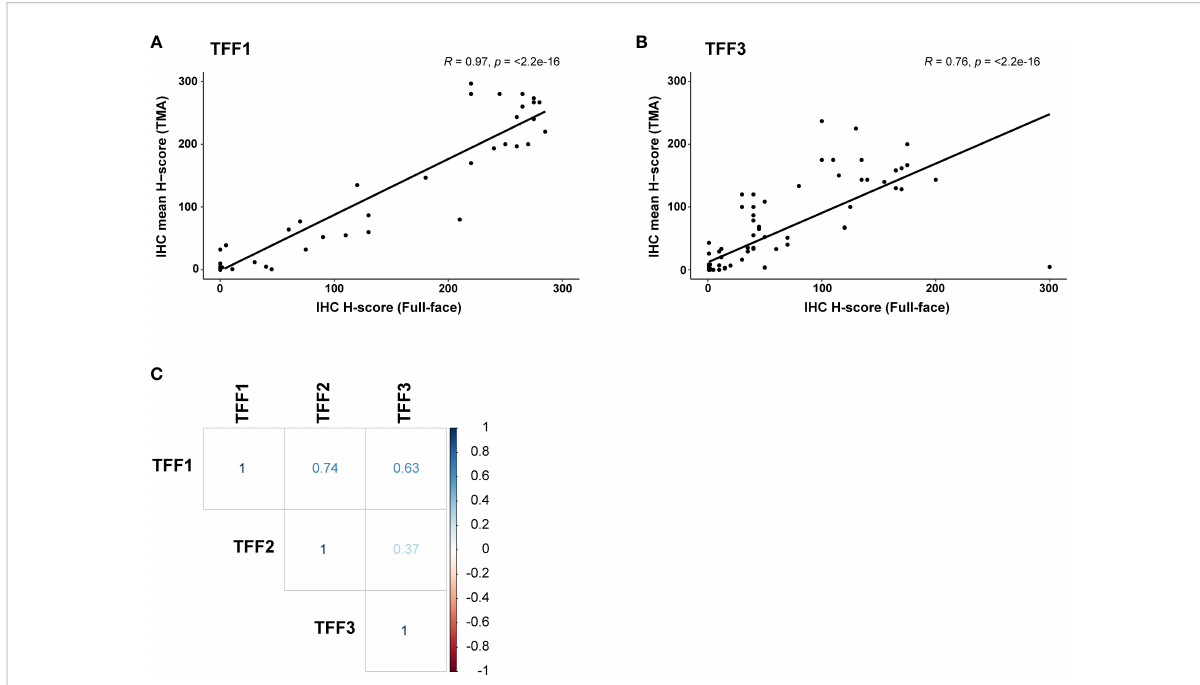
FIGURE 3 Comparison of TFF1, TFF2, and TFF3 protein expression in ovarian carcinoma samples (n=103) using pairwise Pearson correlation. Pearson correlation density plot comparing immunohistochemistry (IHC) scoring in full-face vs TMA samples for (A) TFF1 and (B) TFF3. (C) Using TMAs, TFF1 expression was found to be positively correlated with TFF2 (strong correlation, r > 0.7) and TFF3 (moderate correlation, r > 0.6) expression. No signi fi cant co-expression was found for TFF2 and